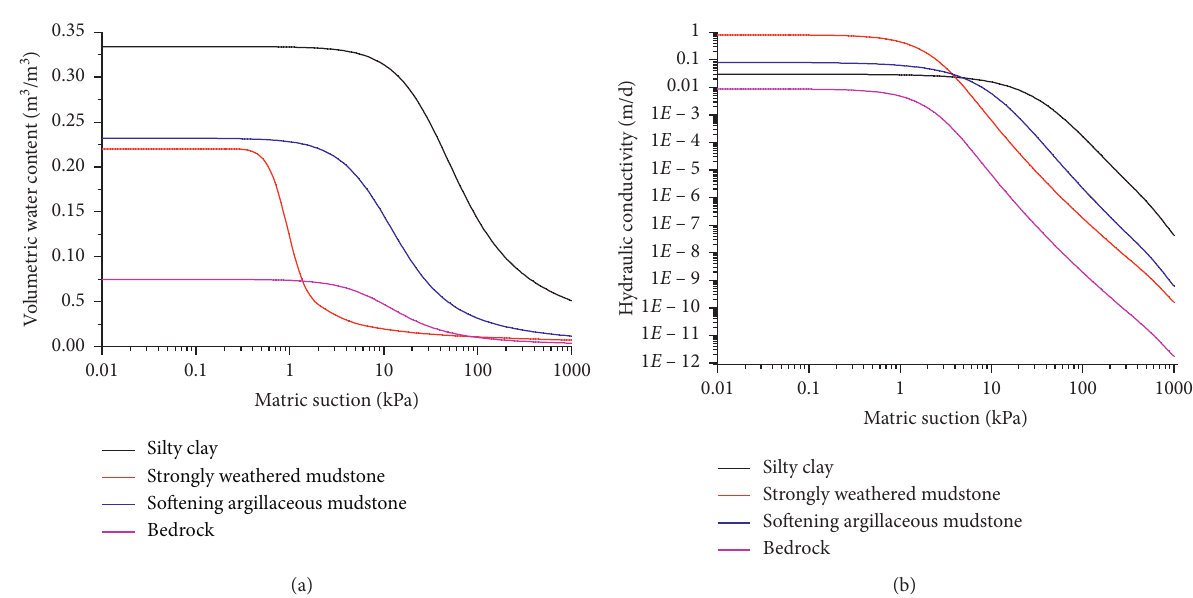
Figure 7: The curve of (a) volumetric water content; (b) hydraulic conductivity and matric